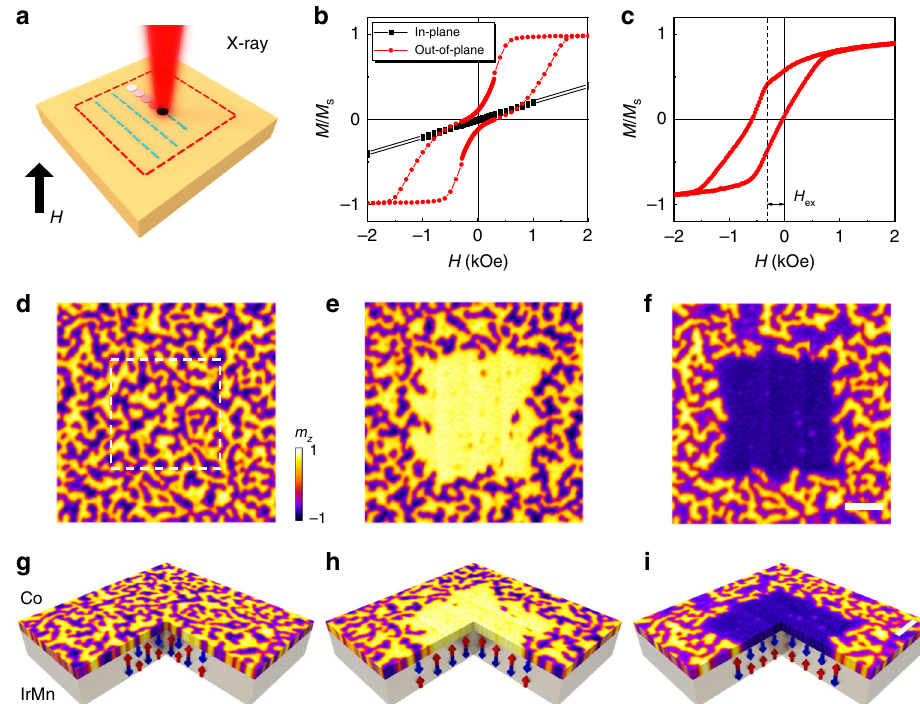
Fig. 1 X-ray induced exchange bias reorientation effect. a Sketch of using synchrotron X-rays to introduce a uniform exchange bias through scanning a closed area (dashed lines) under a perpendicular magnetic fi eld ( H ). The magnetic fi eld indicated by the arrow is along the positive direction. b Out-of- plane (red) and in-plane (black) hysteresis loops for the as-grown sample. c Hysteresis loop at 300 K after fi eld cooling process. The fi eld cooling is performed from 400 K and with the fi eld of 1.5 T. H ex indicates the introduced exchange bias in the out-of-plane direction. d Initial magnetic domain pattern imaged by scanning transmission X-ray microscopy (STXM) at zero magnetic fi eld for a sample with structure of Pt (5)/Co (0.6)/IrMn (2)/[Pt (2)/Co (0.6)/IrMn (2)] 11 /NiO (2) (thickness in nm). e , f Zero- fi eld magnetic domain pattern (6 μ m × 6 μ m) after scanning the central area (3 × 3 μ m 2 ) using a circular X-ray under magnetic fi elds of 2000 Oe ( e ) and − 2000 Oe ( f ). The scanning process induces a uniform exchange bias in the scanned area. The exchange bias direction is along the direction of the applied magnetic fi eld. g – i Schematics of the three-quarter sectional cut of the STXM data and the corresponding exchange bias. The arrows in the IrMn layer schematically indicate the antiferromagnetically ordered net magnetization in the out-of-plane direction. The white scale bar in f , i is 1 μ m.